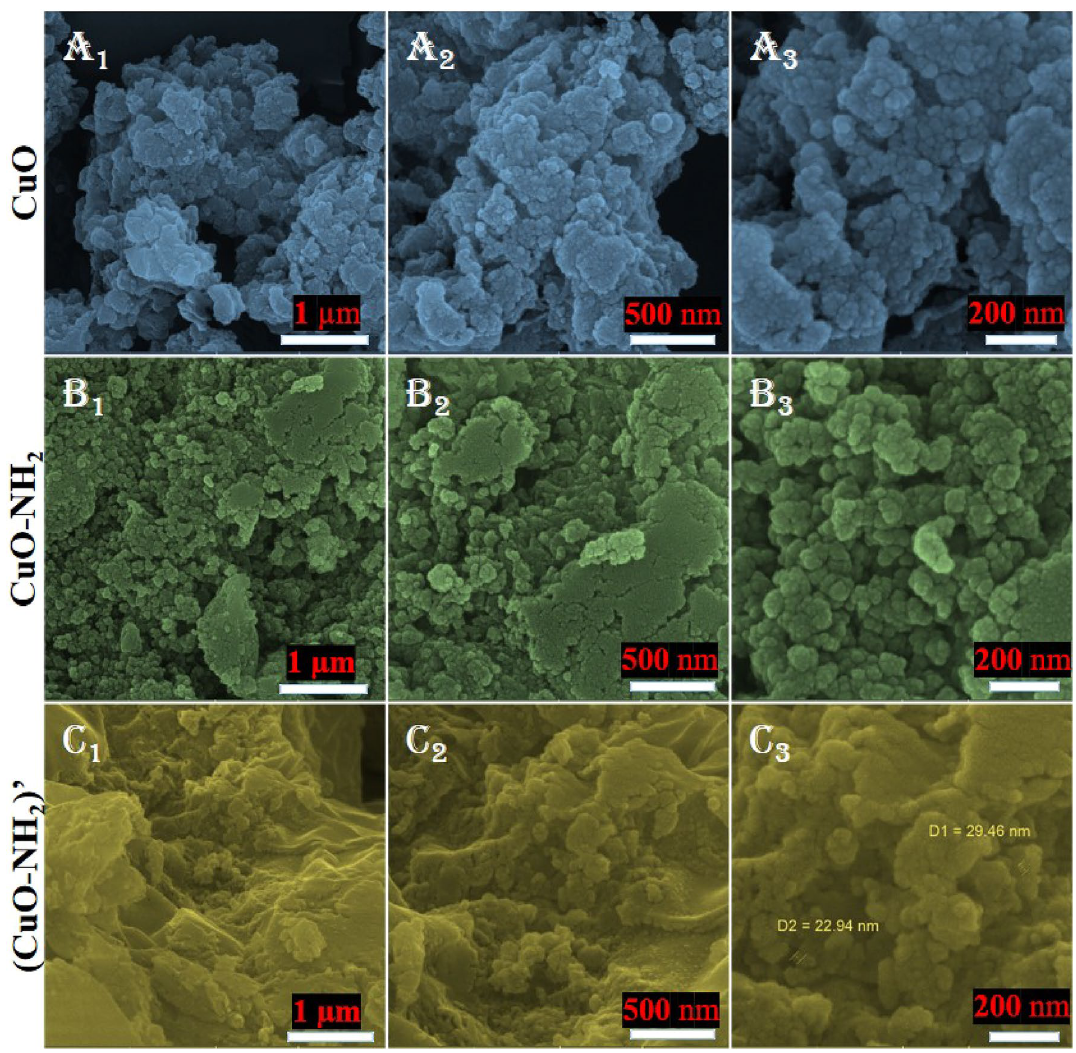
Figure 3. FESEM images of the synthesized CuO: ( A 1 – A 3 ), CuO–NH 2 : ( B 1 – B 3 ), and CuO–NH 2 after photocatalysis process: ( C 1 – C 3